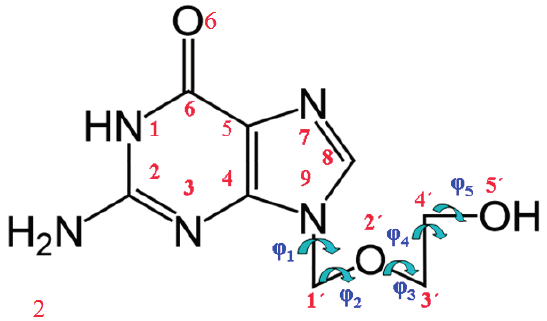
Figure 1. Molecular structure and definition of the torsional angles in tautomer N1 of